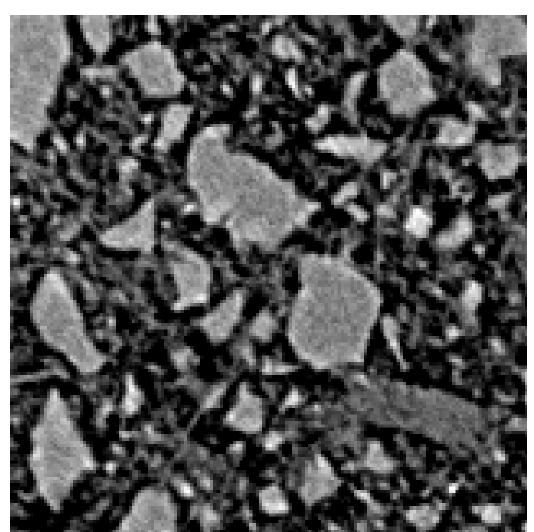
Figure 2. Cropped 2D slice of the tomographic data showing the microstructural features of a hardened cement paste; image size 158 × 158 pixels capturing an area 150 × 150 µm 2